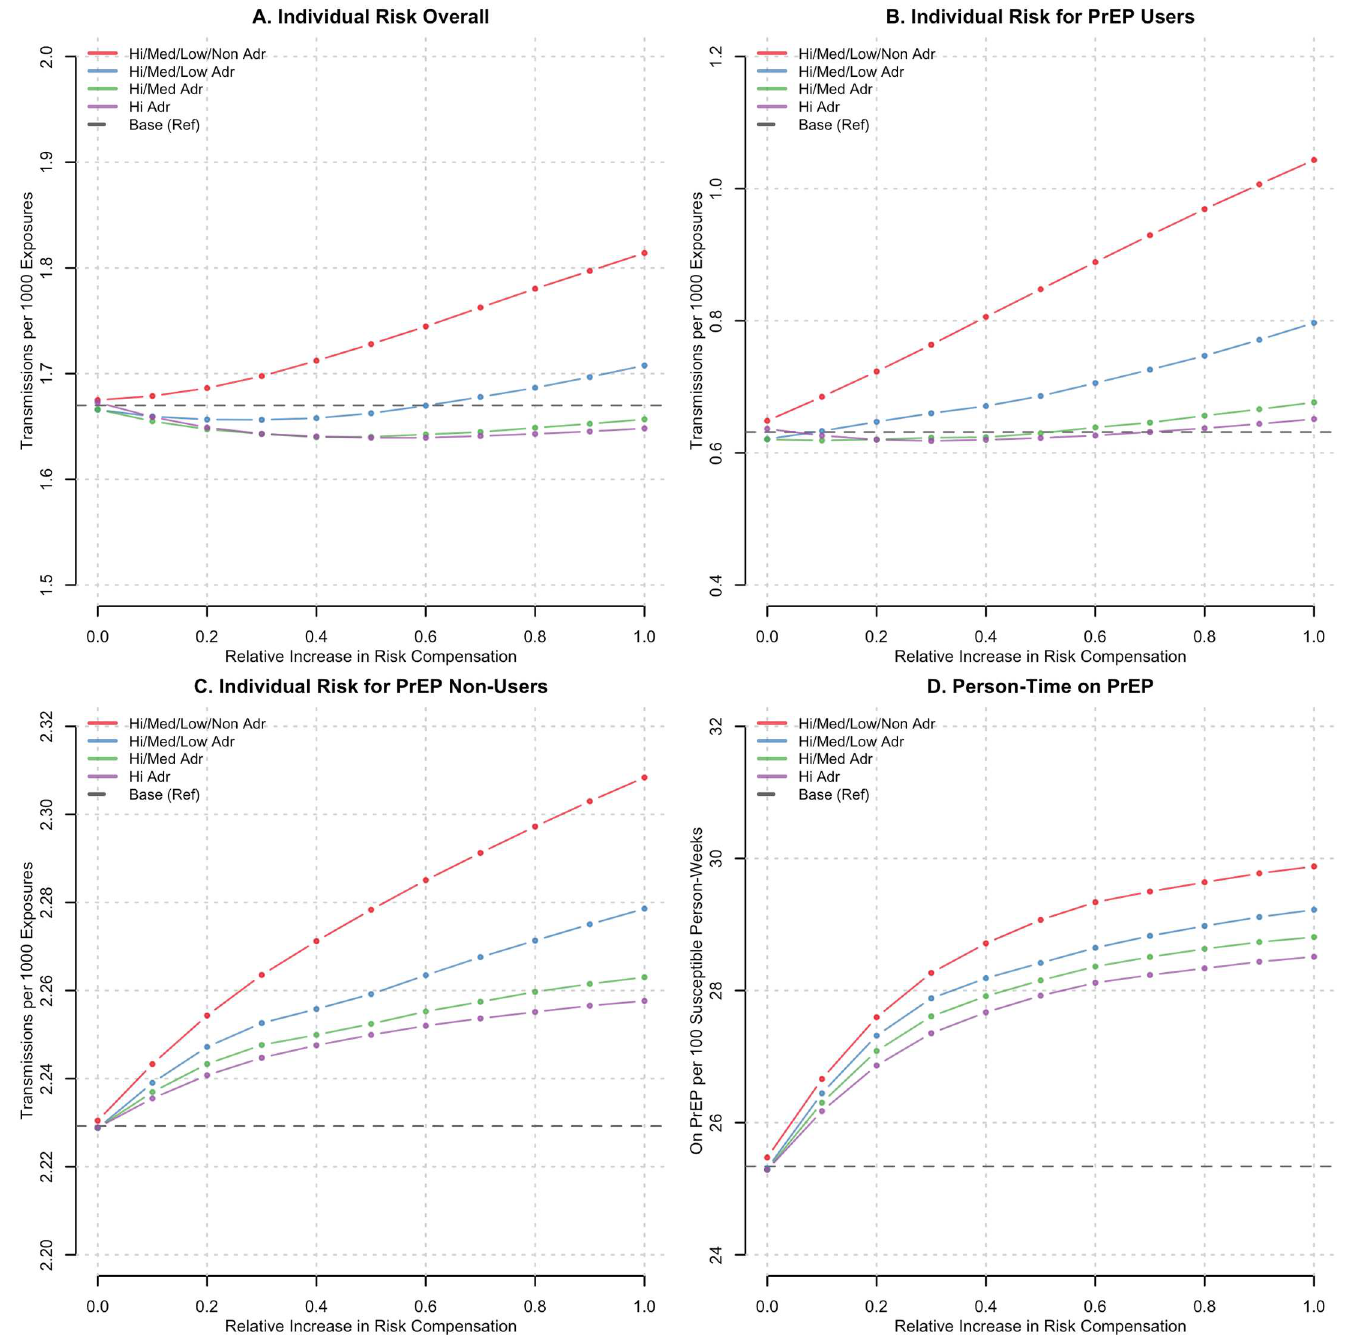
Fig 2. The expectedrate of HIV acquisitionper 1000 discordant exposures for all MSM (Panel A), and for MSM who were currently using PrEP (Panel B) or not using PrEP at the time of exposure(Panel C), by the interaction of relative levels of condom-related risk compensation (RC) and PrEP medication adherence profile in which compensationoccurred. Panel D shows the amount of person-time on PrEP per 100 possibleperson-weeks for susceptible MSM. The red line depicts RC in all four PrEP adherenceprofiles(high, medium, low, and non-adherent), the blue in the top three (high, medium, low) green in the top two (high and medium)and purplein the high only. The horizontal dashedlines shows a comparisonof the two outcomes (incidence and PIA) if RC were not to occur (0% RC). All points summarize the empiricaldistribution of 250 simulations of each scenario.